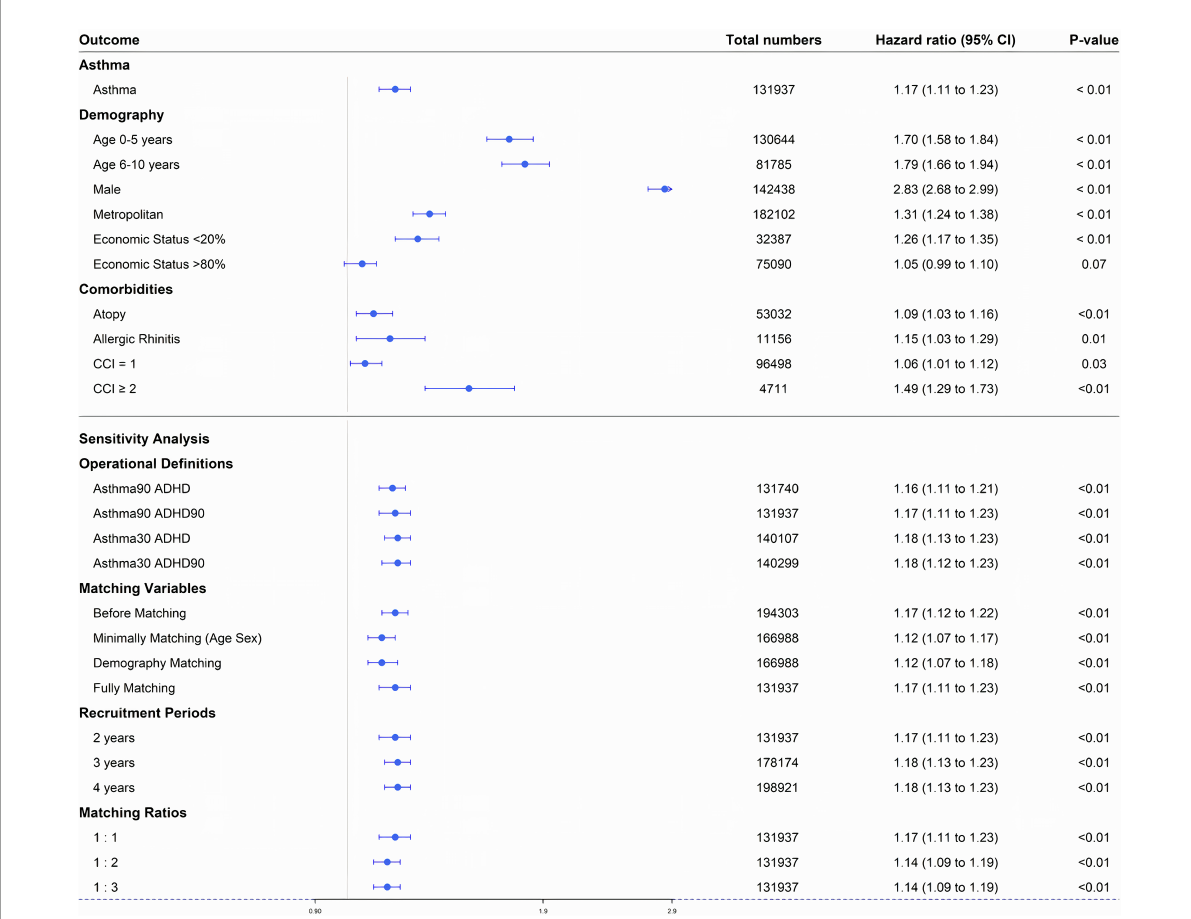
FIGURE3 Study 1. Forest plot of adjusted hazard ratio for each factor in a multivariate Cox proportional hazard model: asthma, sex, economic status, age, residential area, underlying disease (atopic dermatitis, allergic rhinitis), and Charlson comorbidity index. CCI, Charlson comorbidity index. Forest plot of adjusted hazard ratio of asthma factor through sensitivity analyses Asthma90 ADHD, asthma defined by two diagnoses within 90 days and ADHD defined by one diagnosis; Asthma90 ADHD90, asthma defined by two diagnoses within 90 days and ADHD defined by two diagnoses within 90 days; Asthma30 ADHD, asthma defined by two diagnoses within 30 days and ADHD defined by one diagnosis; Asthma30 ADHD90, asthma defined by two diagnoses within 30 days and ADHD defined by two diagnoses within 90